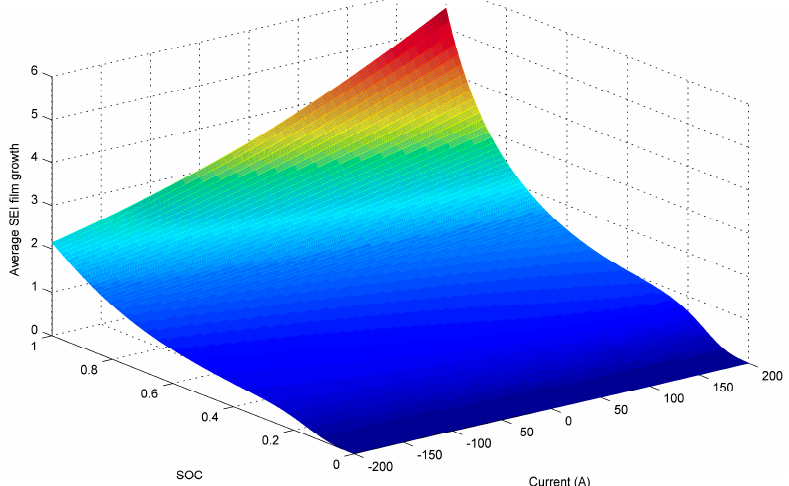
Figure 3. Steady map of film growth rate versus current and the SOC.